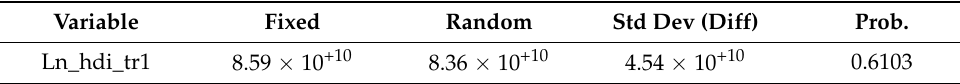
Table 3. Hausman Test Turkey.